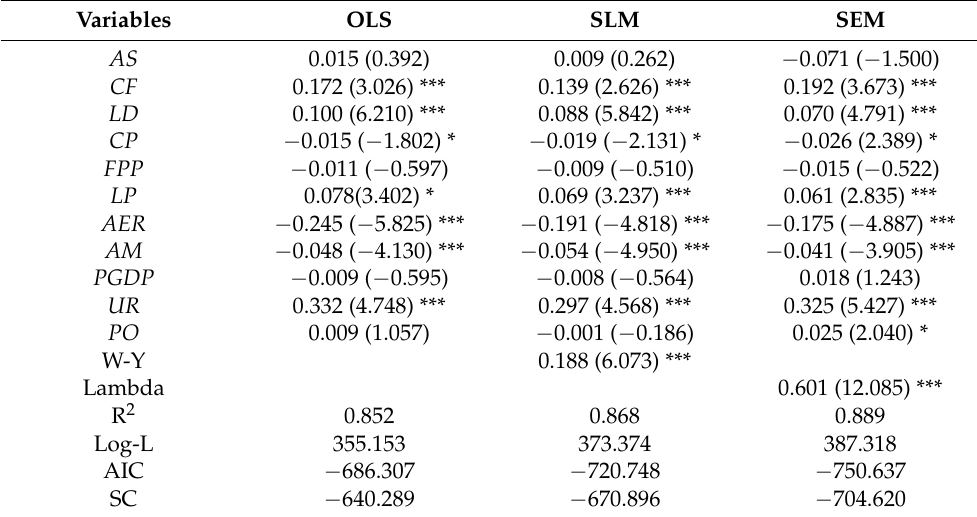
Table 2. Results of the spatial econometric